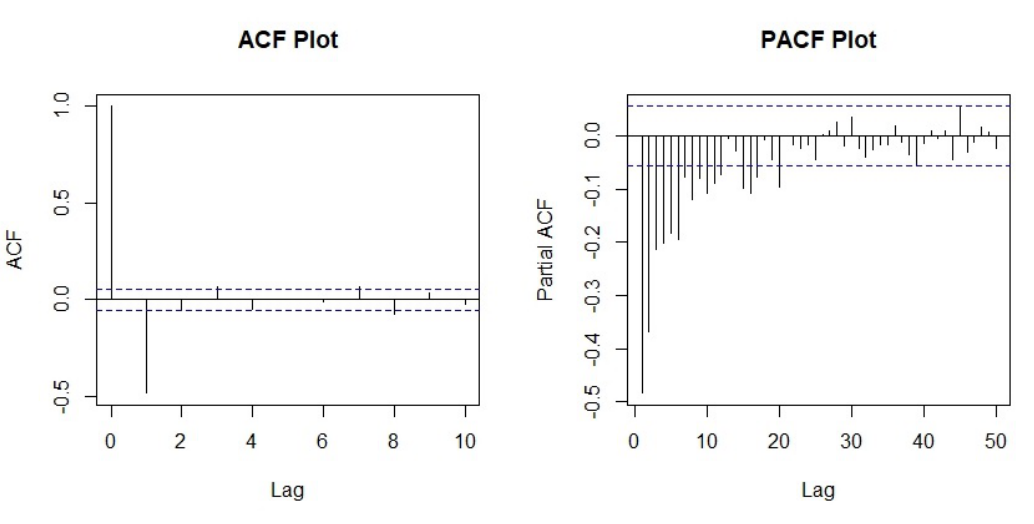
Figure 4. ACF and PACF of the second differenced log transformed stock